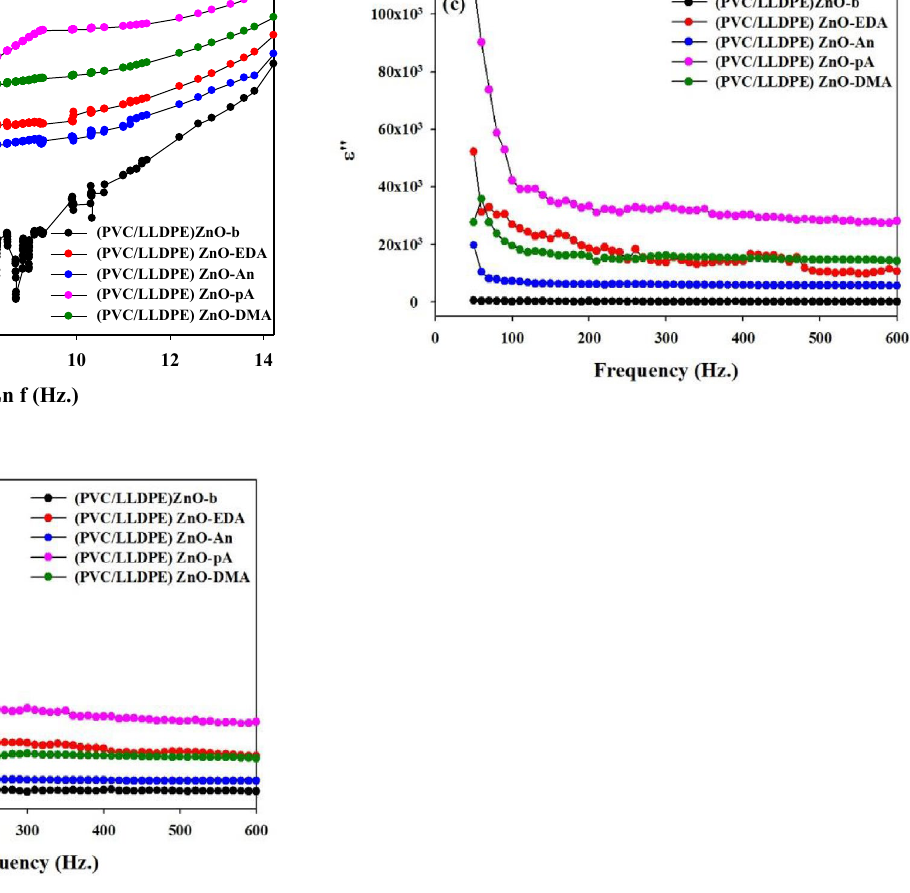
Figure 8. ( a ) The AC electric conductivity, ( b ) permittivity ε ʹ and ( c ) the dielectric loss ε ʺ at room temperature ~ 25 °C of aminated modified PVC as a function of